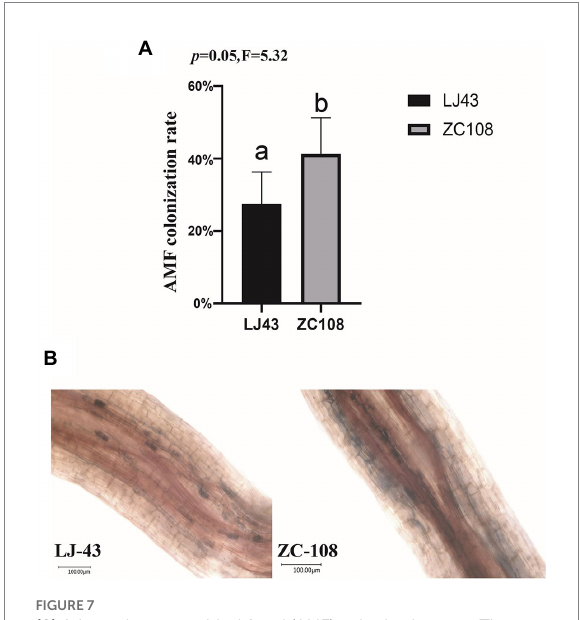
FIGURE 7 (A) Arbuscular mycorrhizal fungi (AMF) colonization rate. The root length colonization rate (RLC%) of two varieties was counted, and 5 replicates were used for each variety. (B) Trypan blue stained roots showing AMF colonization in two varieties. Photographs were taken with an Ultra-depth microscope. Mean values ± standard error ( n = 5); different letters indicate a significant difference ( p = 0.05) based on one-way ANOVA followed by an LSD